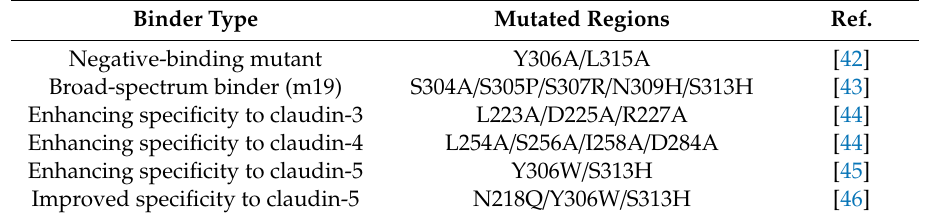
Table 1. List of claudin-binding mutants of C-terminal receptor binding domain of Clostridium perfringens enterotoxin.